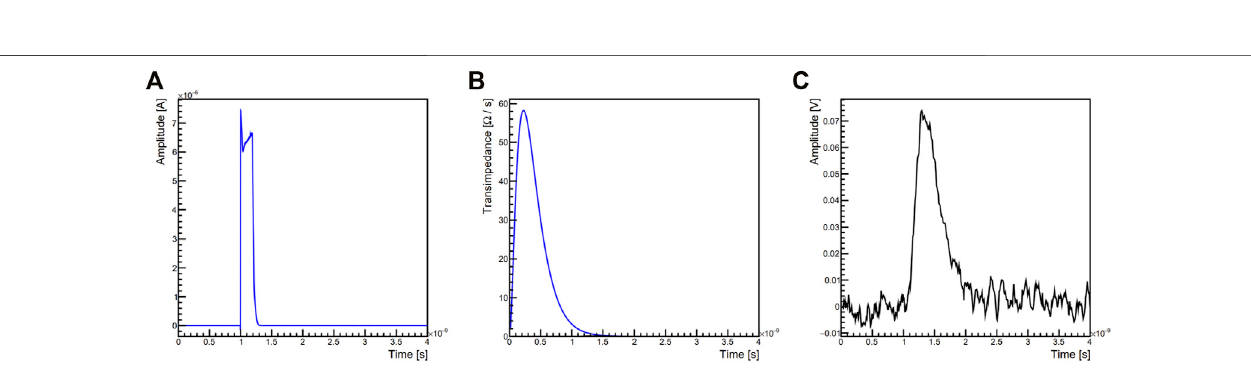
FIGURE 6 | : Example of the result of the front-end simulation for a single input current from TCoDe, for a 3D-trench double pixel structure at − 150 V bias voltage. (A) Input current for a MIP deposition in the sensor (center) simulated analytical transimpedance and (B) output signal waveform with red noise.